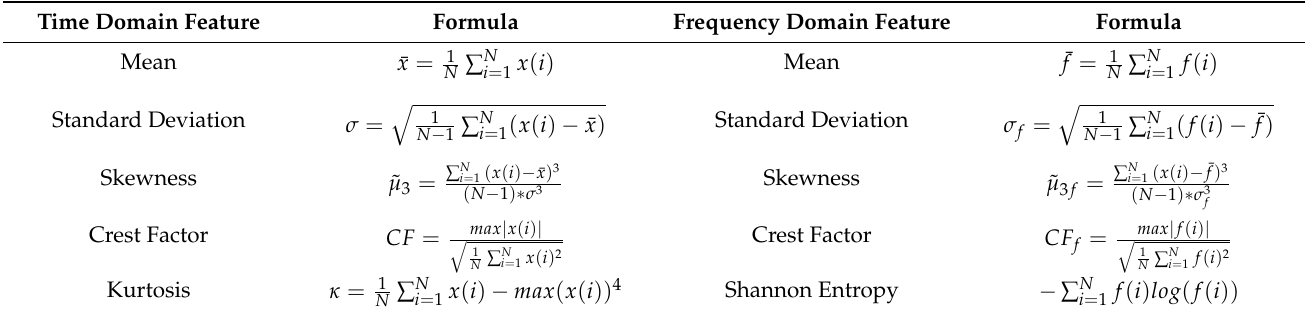
Figure 9. t-SNE visualization of the generated data. Table 1. Selected features for analysis of the generated fault